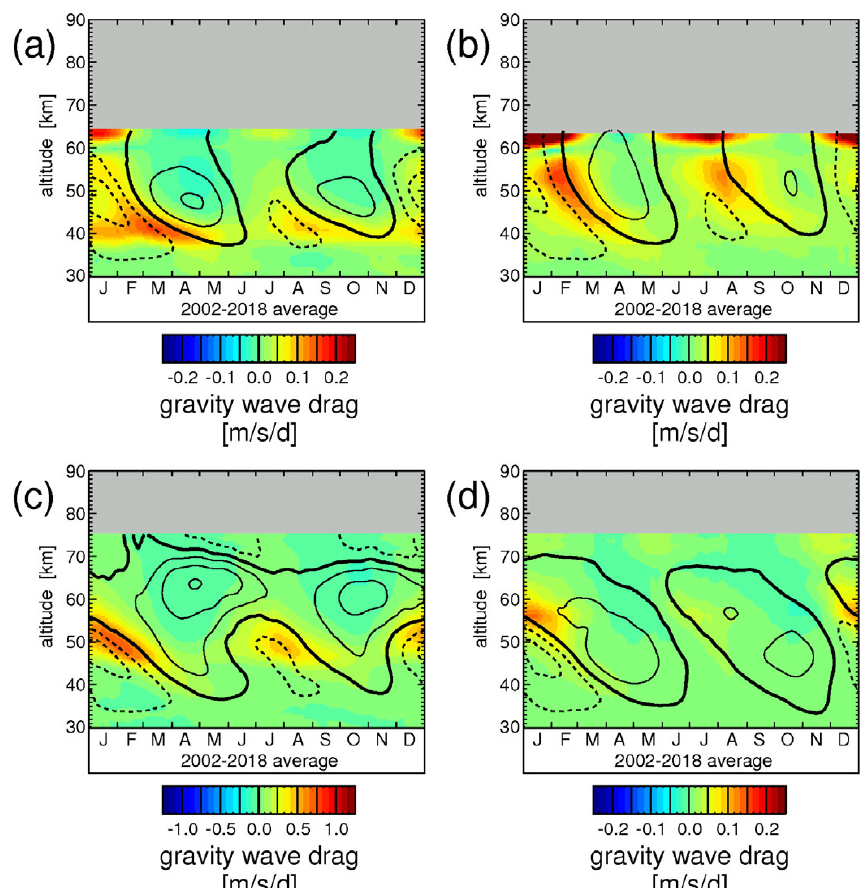
Figure 5. Same as Fig. 4 but for the zonal gravity wave drag X res (k > 20 ) of model-resolved gravity waves at zonal wavenumbers exceeding k =